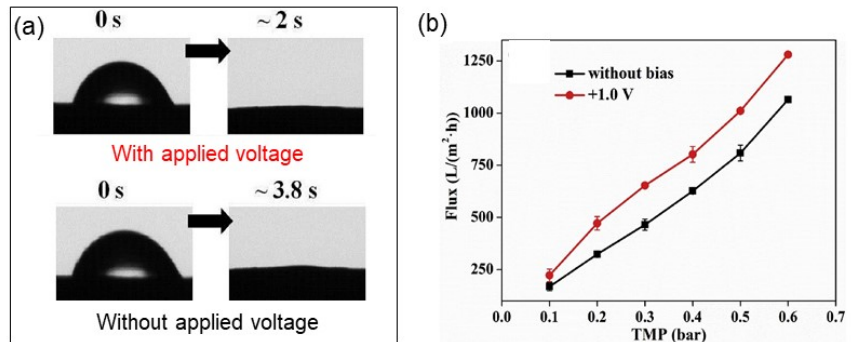
Figure 9. ( a ) Changes in surface water contact angle of carbon nanotube-based hollow fiber membranes (CNT-HFMs) with ( upper ) and without ( bottom ) an applied voltage over time. ( b ) Changes in water flux across the CNT-HFMs with/without an applied voltage as a function of transmembrane pressure. Reproduced with permission from